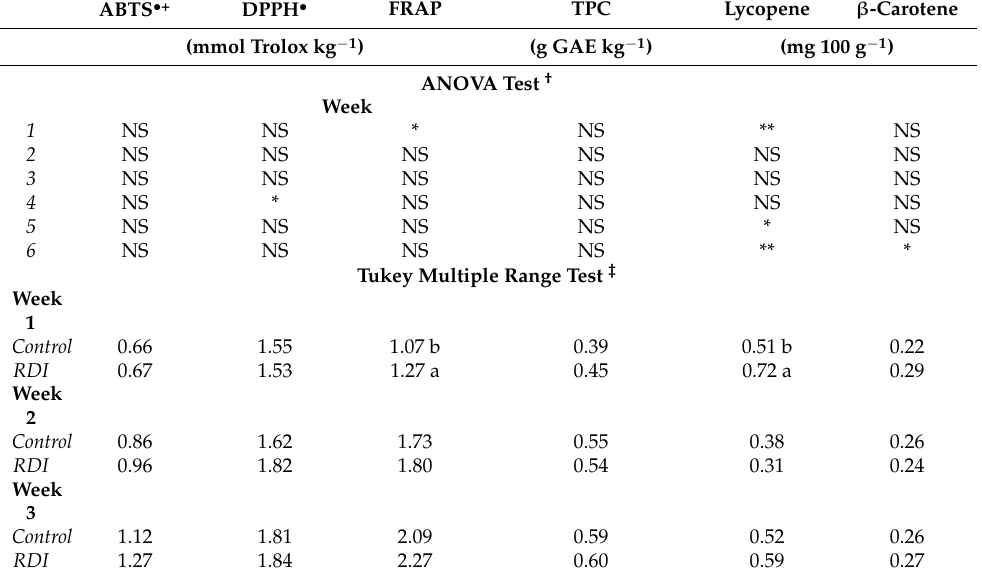
Table 4. Antioxidant activity (ABTS • + , DPPH • , and FRAP) and content of lycopene, β -Carotene and total polyphenol content (TPC) in cherry tomatoes as affected by irrigation treatment and